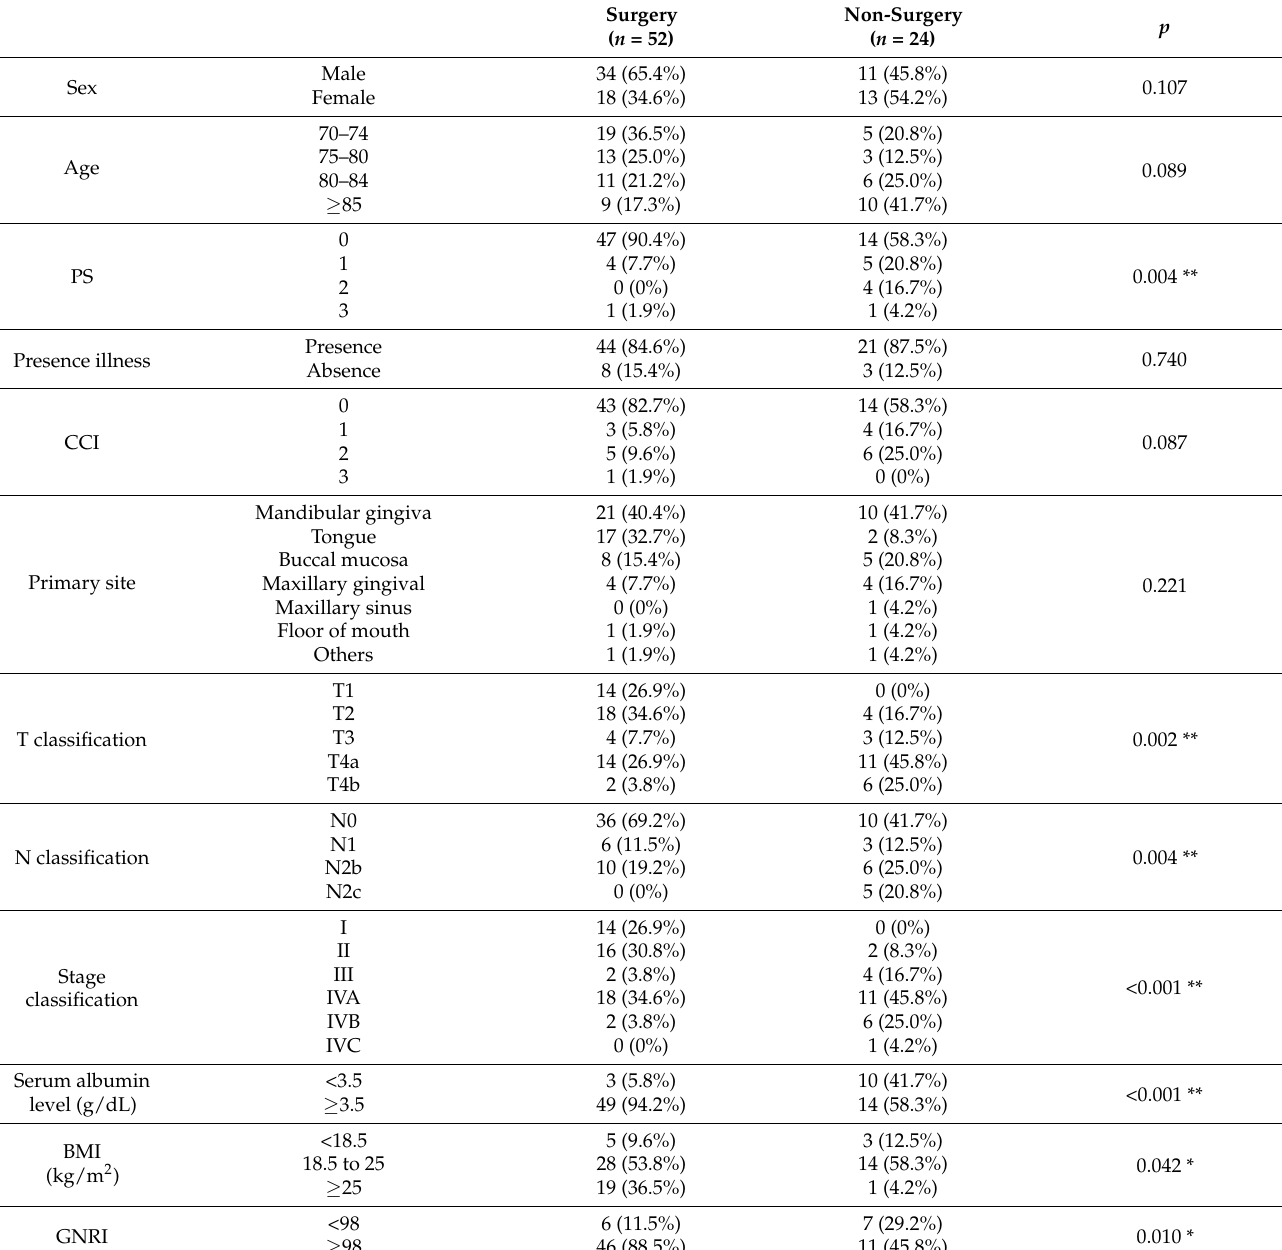
Table 1. Clinical characteristics for surgery group and non-surgery